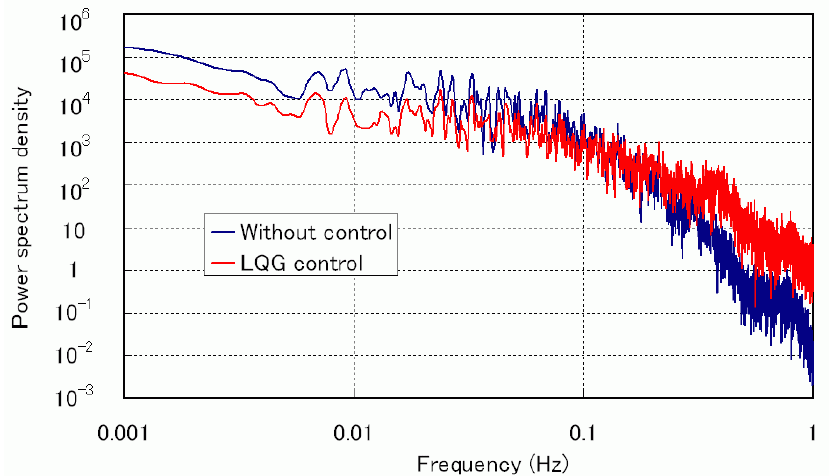
Figure 10 Comparison of spectrum analysis